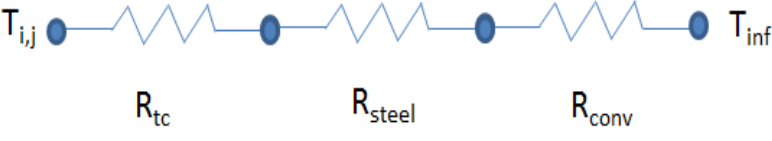
Figure 5. Clamped boundary thermal resistance.